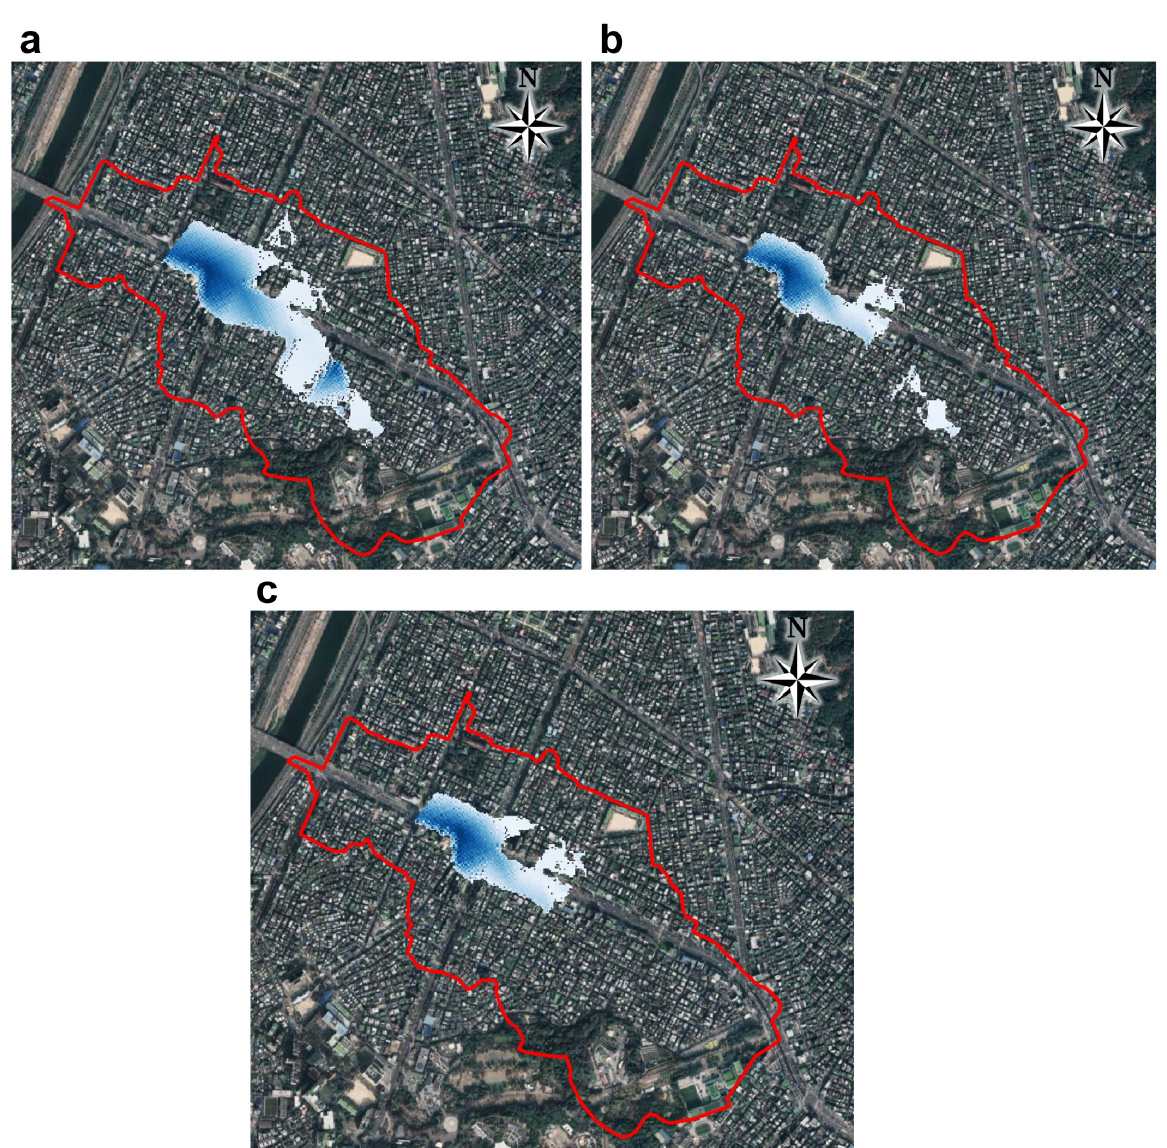
Figure 12. Flood analysis according to the reduction facility installation conditions in the Gunja watershed. ( a ) Not installed, ( b ) installation of the underground storage tank, and ( c ) installation of the trunk drainage sewer. Table 5. Flood analysis according to the reduction facility installation conditions (Gunja watershed).